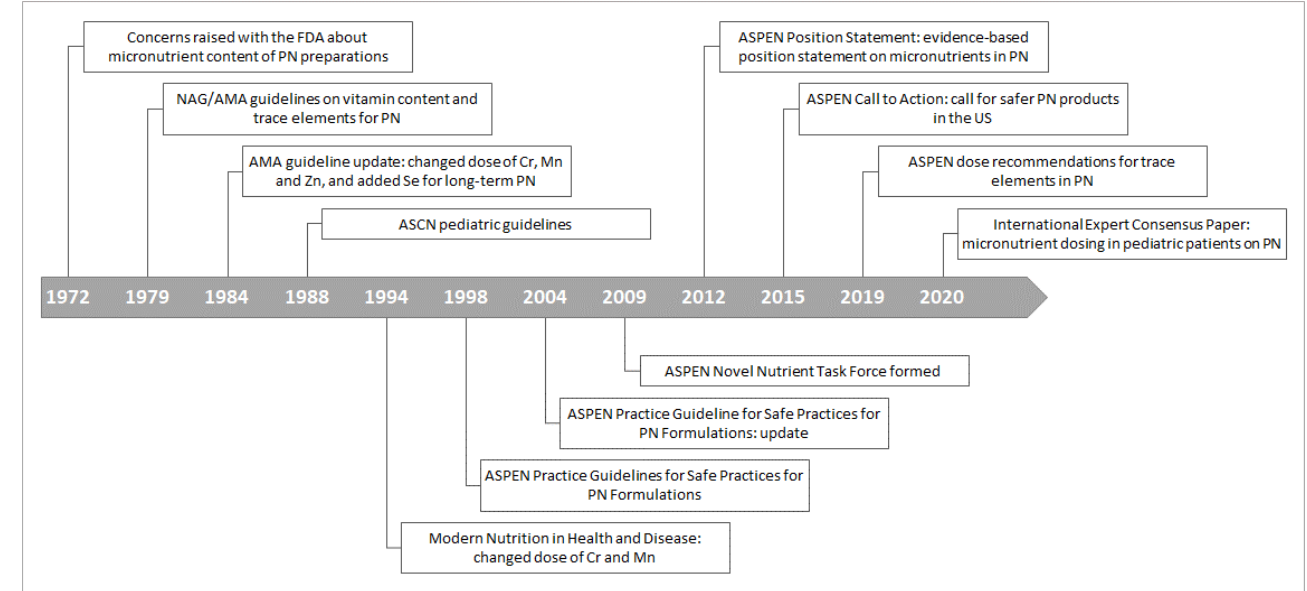
Figure 1. Timeline in the development of current US recommendations for dosing of trace elements in parenteral nutrition [8]. AMA, American Medical Association; ASCN, American Society for Clinical Nutrition; ASPEN, American Society for Parenteral and Enteral Nutrition; Cr, chromium; FDA, United States Food and Drug Administration; Mn, manganese; NAG, Nutrition Advisory Group; PN, parenteral nutrition; Se, selenium; US, United States; Zn, zinc.